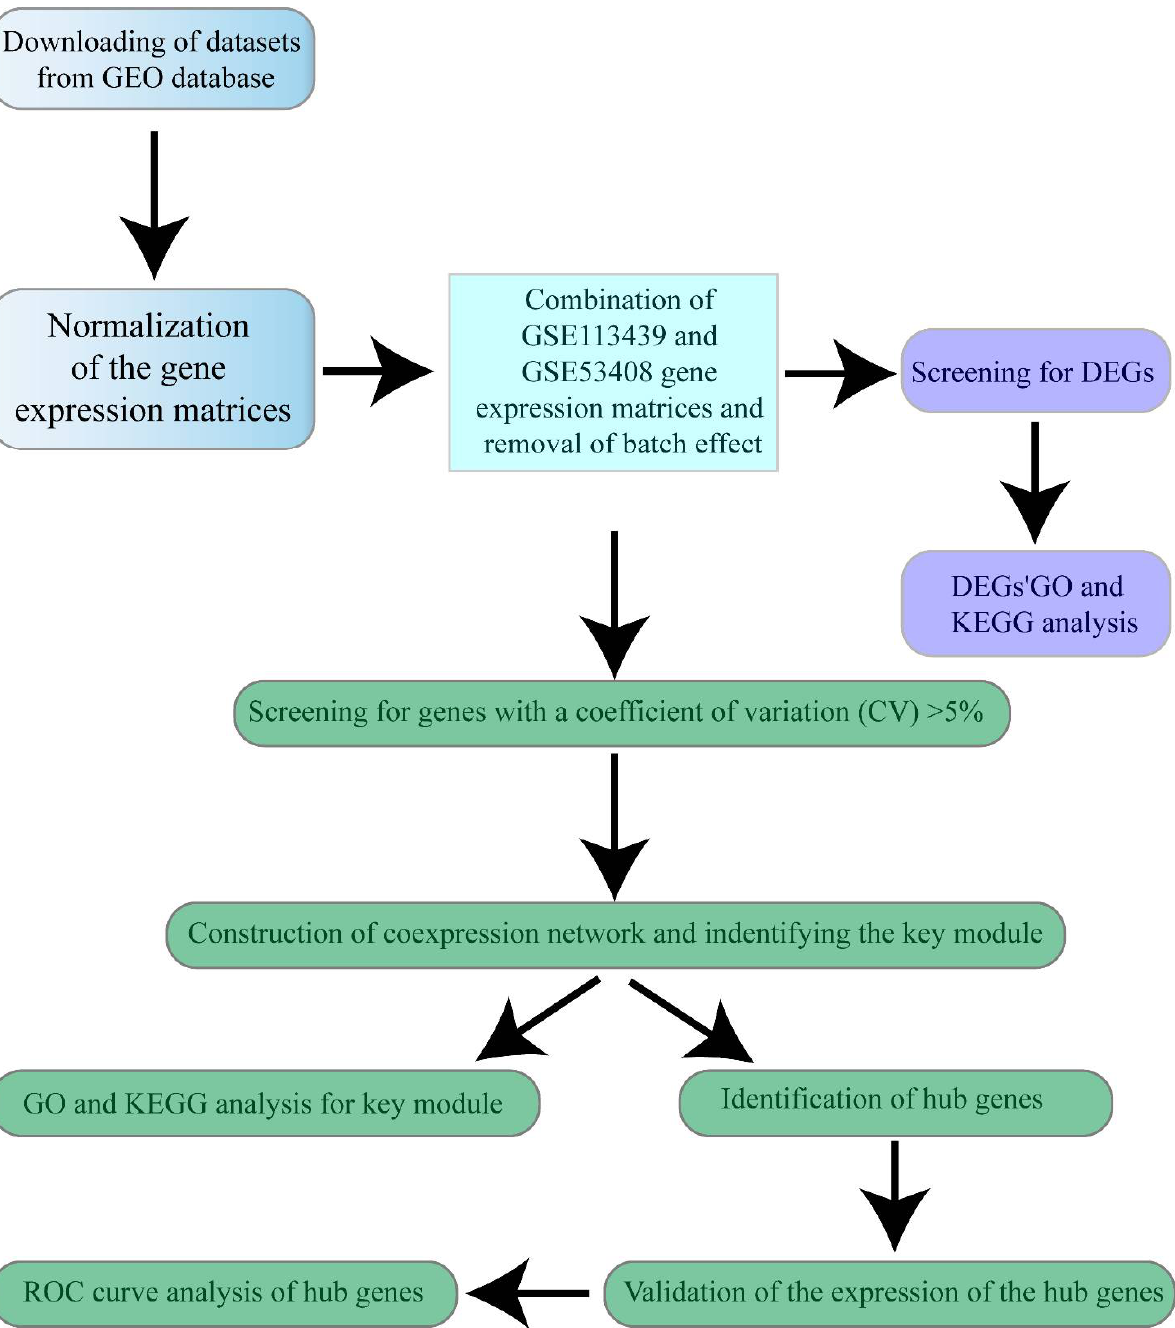
Figure 1. Workflow of the study design.